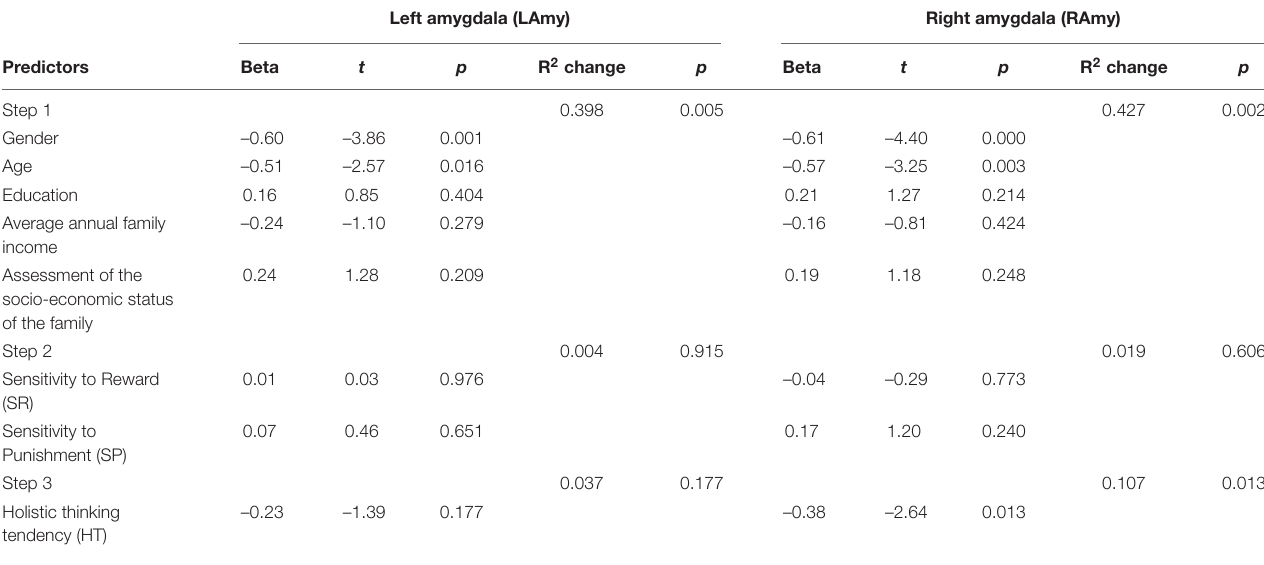
TABLE 3 | Hierarchical regression predicting the volume of left and right amygdala. Left amygdala (LAmy) Right amygdala